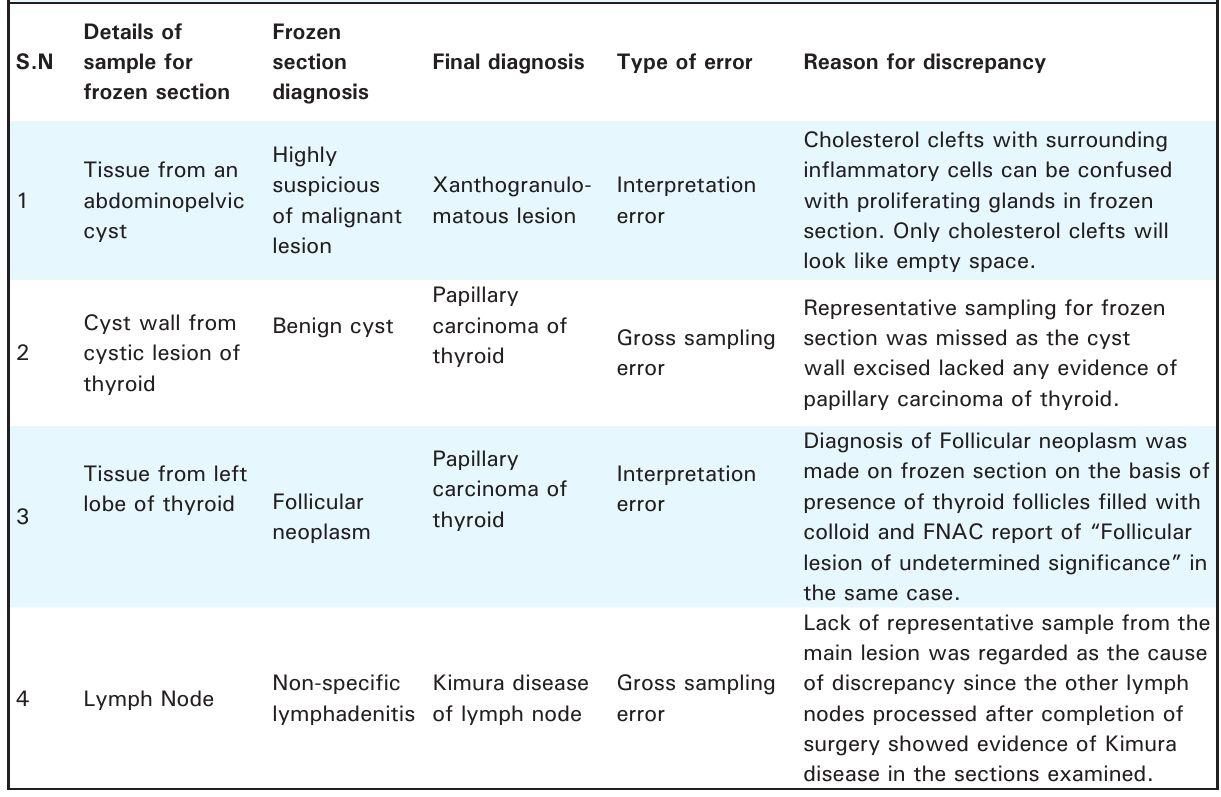
Table 4. Details of discordant